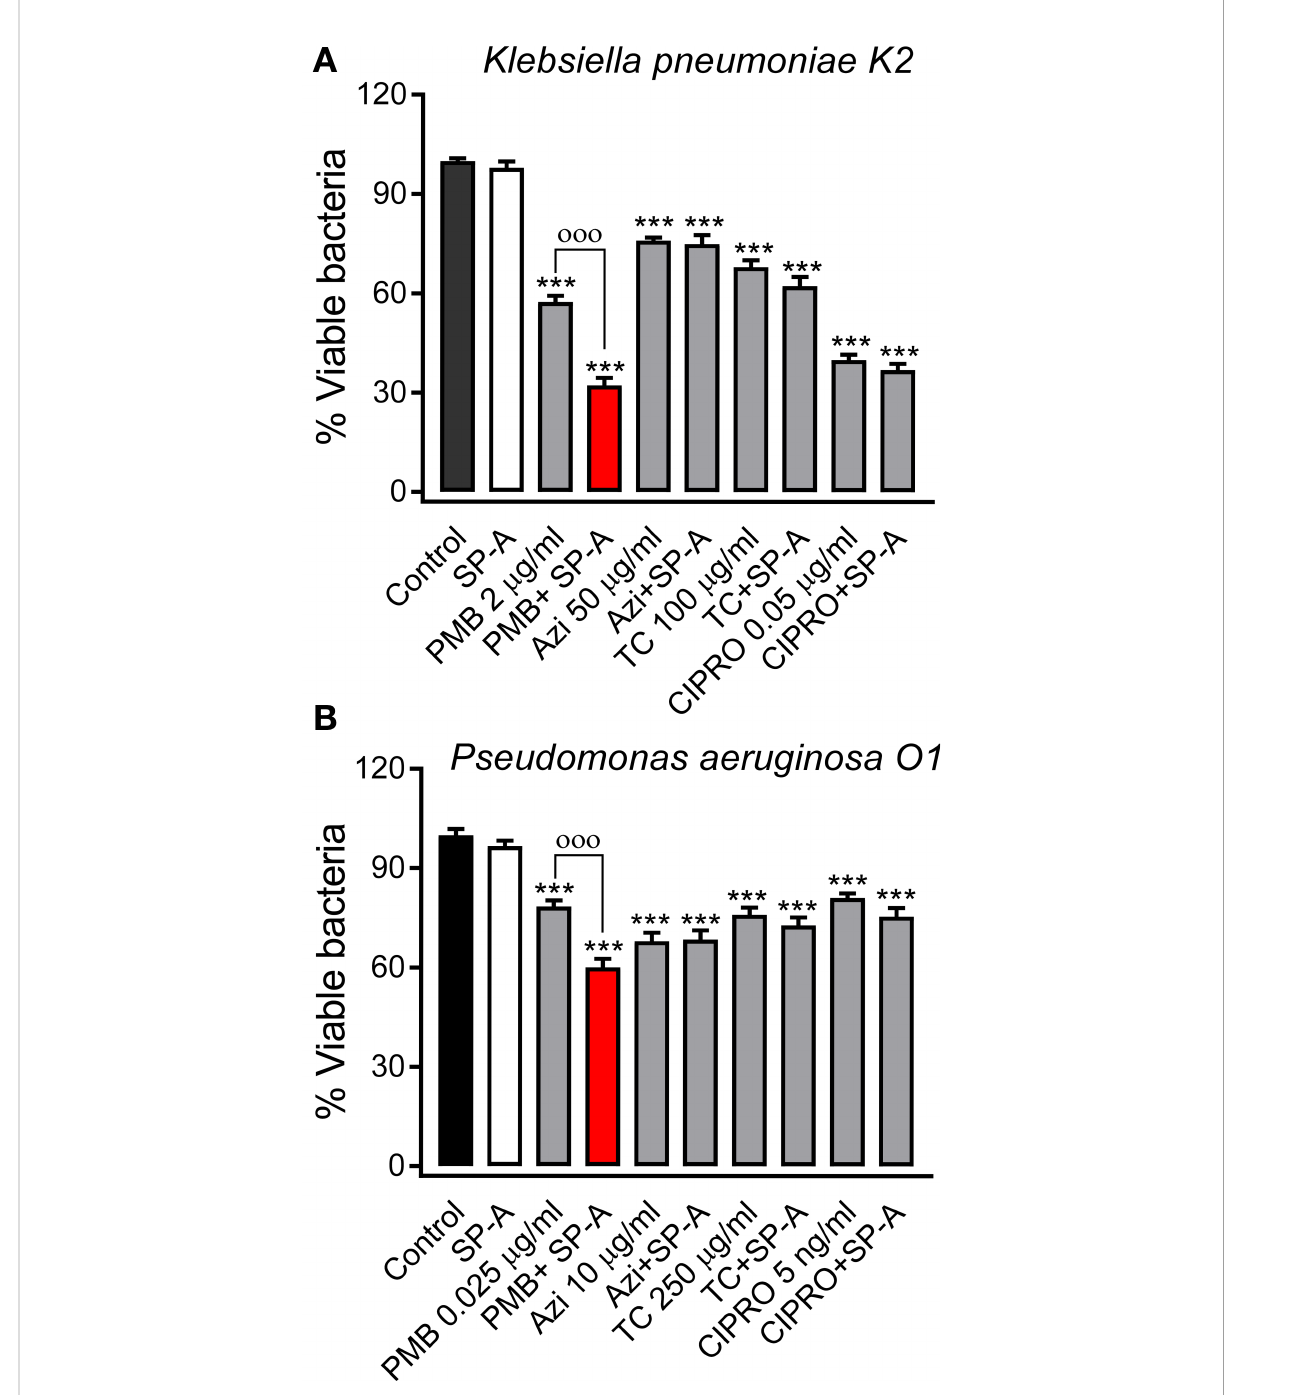
FIGURE 3 SP-A has synergic antimicrobial activity with polymyxin B (PMB), but not with azithromycin (AZI), tetracycline (TC), and cipro fl oxacin (CIPRO), against Gram-negative bacteria. 10 5 CFU/ml of K pneumoniae (A) or PAO1 (B) were incubated with conventional antibiotics, at the indicated concentrations, in the absence or presence of SP-A (100 m g/ml) in 10 mM phosphate buffer (pH 7.4), 1% TSB, and 100 mM NaCl for 1h at 37°C. Then, the bacteria were plated on LB agar for CFU count after 18 h of incubation at 37°C. The results are shown as % viable bacteria (percentage of live colony counts compared with untreated control). SP-A alone was unable to kill capsulated K pneumoniae or PAO1, as previously reported (25). Data are the means ± SD of three independent experiments with at least three biological replicates. A value of p < 0.001 was obtained for the one-way ANOVA, followed by the general multiple-comparison Bonferroni test: *** p < 0.001 when comparing antibiotic treatment vs. the control untreated group; ооо p < 0.001 when comparing SP-A+antibiotic treatment vs. the antibiotic-treated